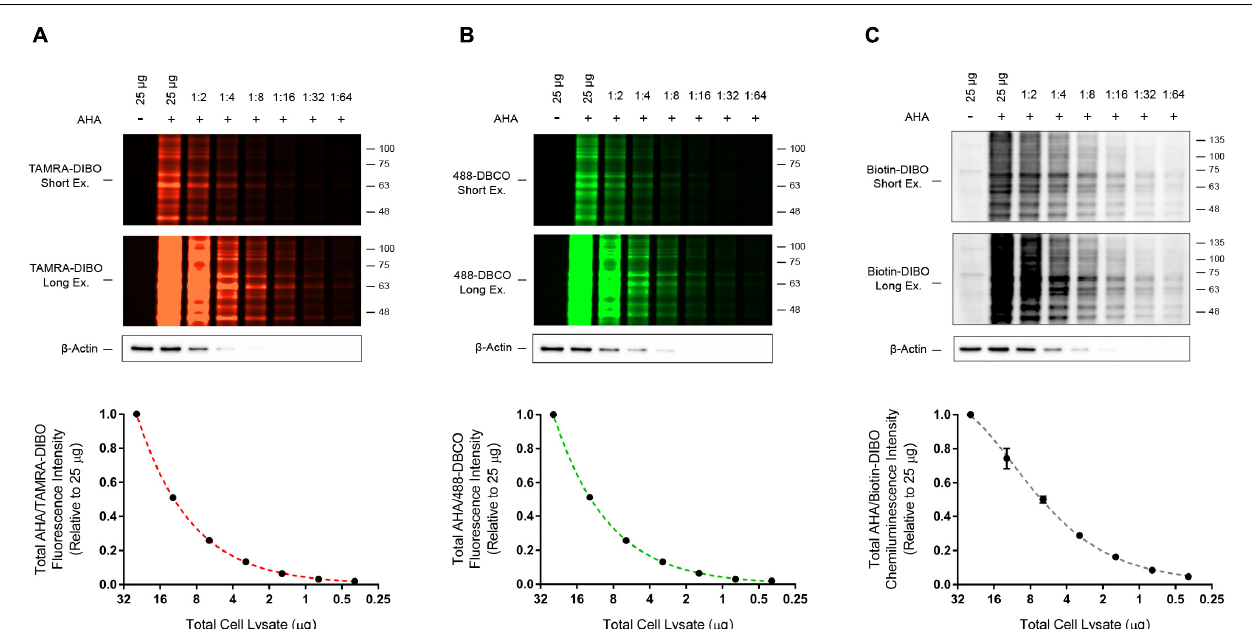
FIGURE 4 | Detection sensitivity comparison for three different strained cyclooctyne probes. HEK293 cells were live-labeled in culture for 4 h with 50 µ M AHA then collected immediately without a methionine chase. Control unlabeled cells were incubated in media with methionine (i.e., without AHA). Cells were lysed and AHA-labeled protein samples from whole cell lysates were reacted with the strained cyclooctynes (A) TAMRA-DIBO, (B) 488-DBCO, or (C) Biotin-DIBO. AHA/cyclooctyne-labeled proteins were denatured in 1 × Laemmli sample buffer, then serially diluted 1:1 with 1 × Laemmli sample buffer a total of six times until reaching a final dilution of 1:64. Protein samples were run on SDS-PAGE gels and AHA-labeled proteins were detected in-gel at an Ex/Em of either 555/580 nm ( A ; TAMRA-DIBO) or 494/517 nm ( B ; 488-DBCO). Alternatively, AHA-labeled proteins reacted with Biotin-DIBO (C) were resolved on SDS-PAGE gels, then transferred to PVDF membranes and detected by chemiluminescence using HRP-conjugated streptavidin. Anti-actin immunoblots were completed as a loading control. Overall, similar detection sensitivity was observed between AHA-labeled protein samples reacted with TAMRA-DIBO, 488-DBCO, or Biotin-DIBO ( n =